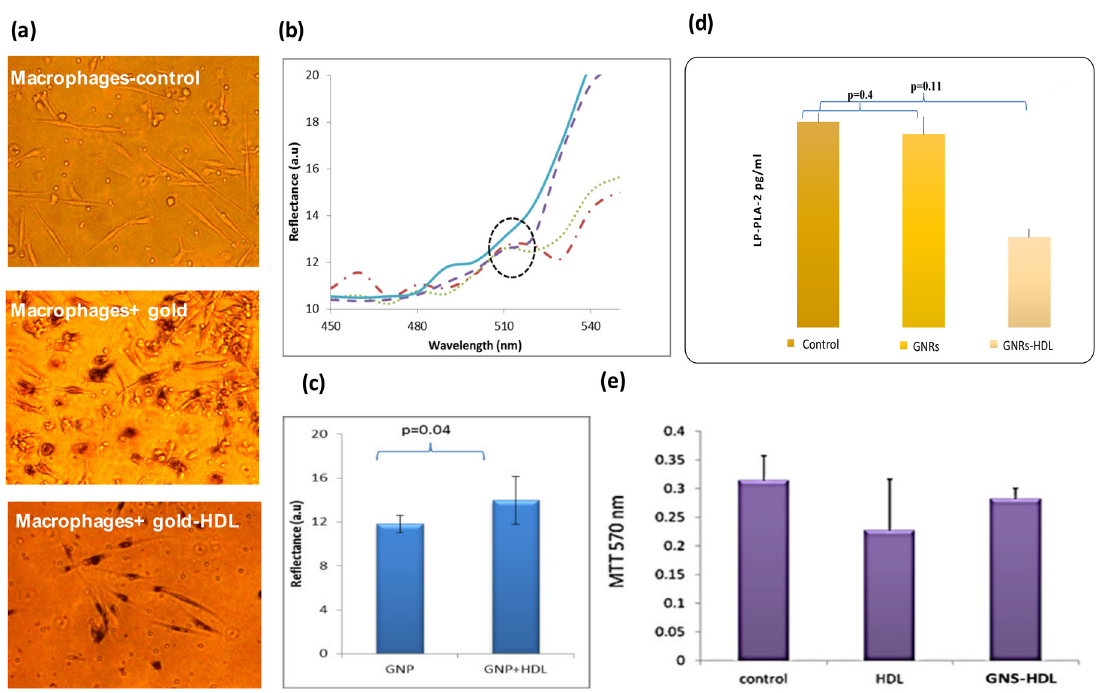
Figure 2. In vitro measurements of macrophage cell culture following incubation with GNSs and GNS-HDL. ( a ) GNSs uptake by macrophages captured by inverted microscopy. Nanoparticles appear as dark dots within cells due to light absorption by the particles. All experiments were